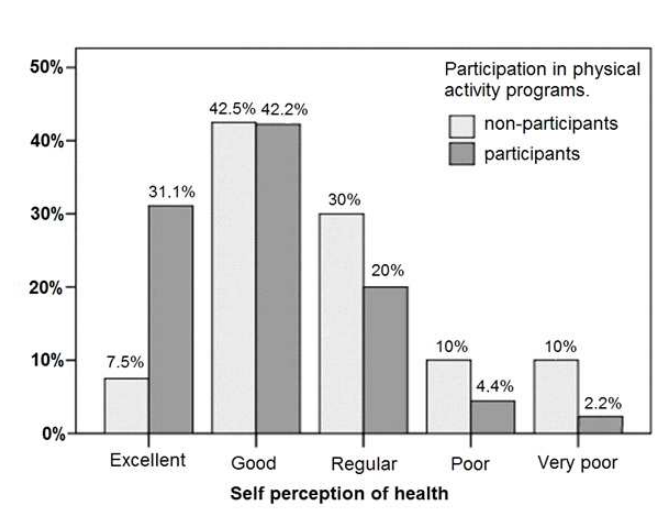
Figure 1. Self-perceived health by the older participants and non- participants of physical